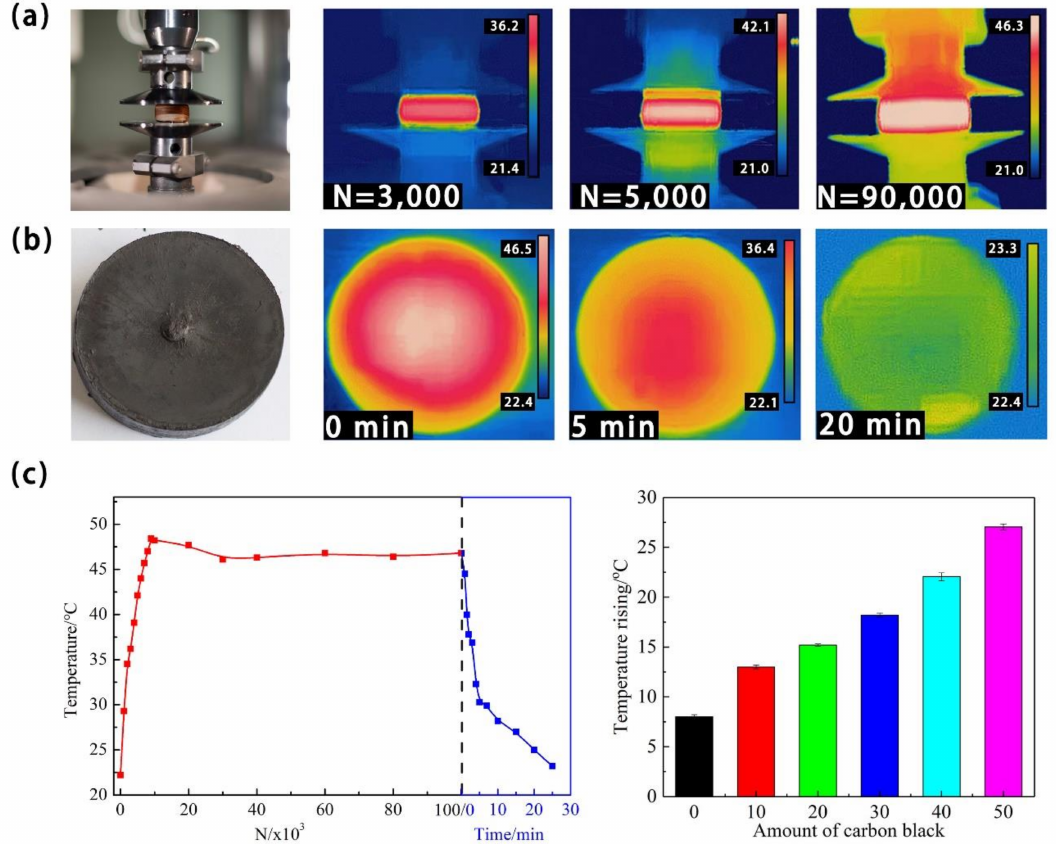
Figure 3. ( a ) Photo and IR images of filled SBR 3 during the compressive loading process, ( b ) photo and cooling process of SBR 3 after 10 4 cycles, ( c ) temperature cycles/time curve of SBR 3 during the whole compression fatigue and cooling process and heat build-up properties of SBR with different carbon black